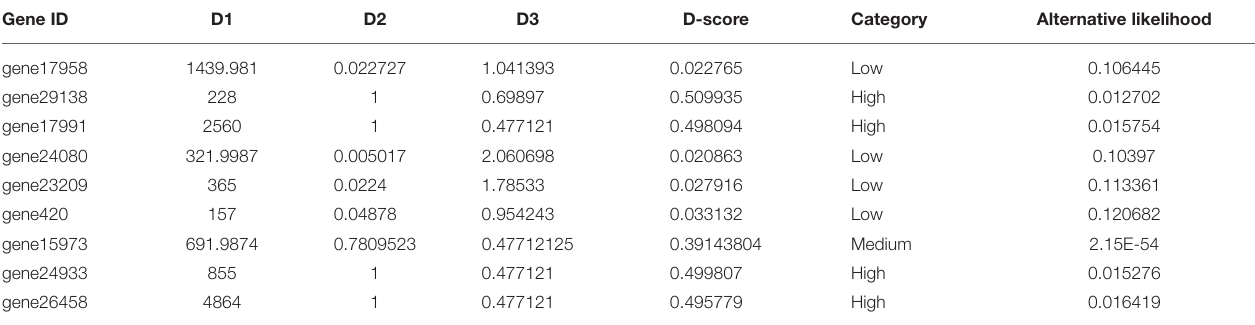
TABLE 2 | GeneQC example output.